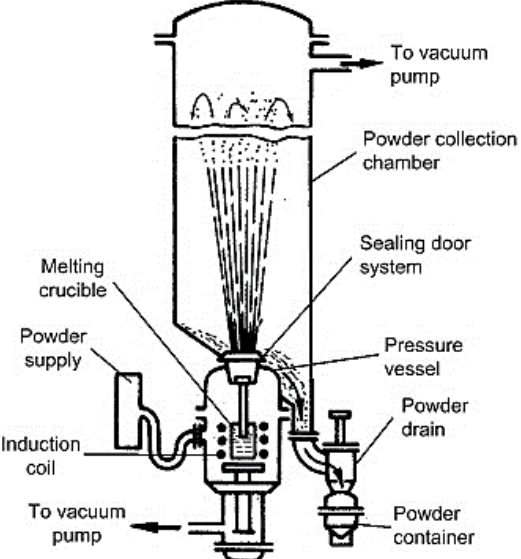
Figure 1. Gas atomisation (GA) schematic, reproduced from [22], with permission from Elsevier,